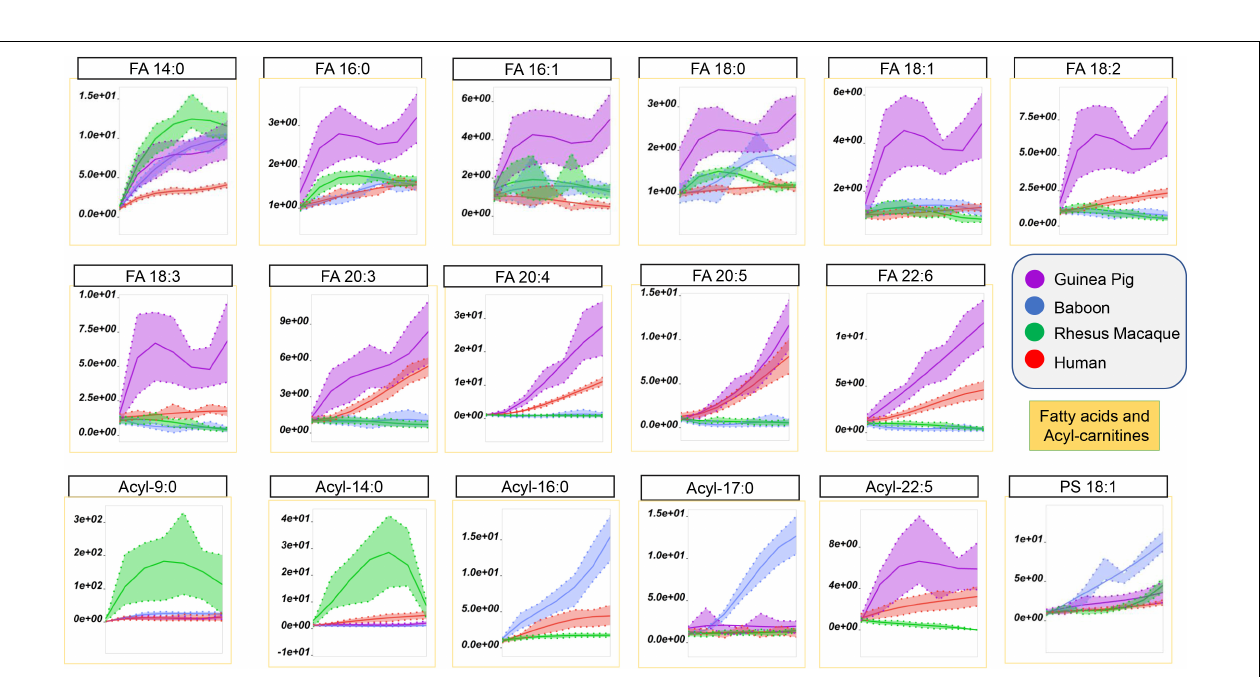
FIGURE 7 | Impact of storage on free fatty acids and acyl-carnitines in RBCs from guinea pigs (violet), baboons (blue), rhesus macaques (green), and humans (red). Line plots indicate metabolite medians (lighter colored areas are ranges) normalized to measurements in fresh, non-stored blood (day 0) and autoscale normalized across groups. All metabolites are significant by ANOVA (FDR corrected– p < 0.05).